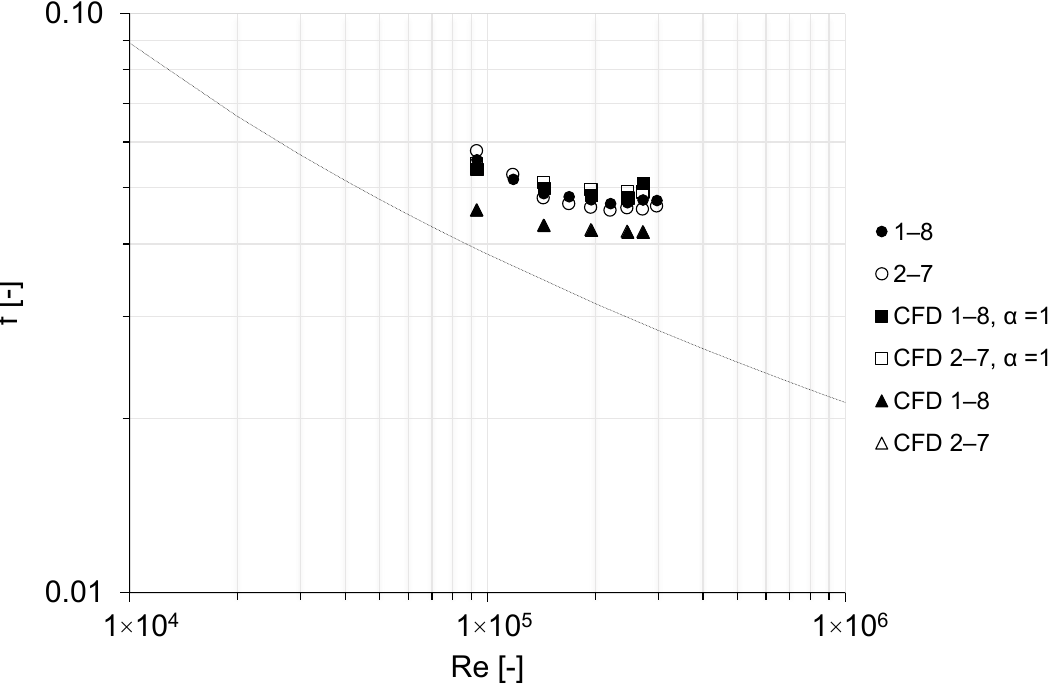
Figure 9. Friction factors for the reaches 1–8 and 2–7 as a function of Reynolds number determined from the experimental and numerical data (for α = 1 and α determined from velocity distributions). The line indicates the transition to hydraulic rough conditions for different values of k/D P . Note that identical values were obtained for the numerical data when α was determined from velocity distributions.